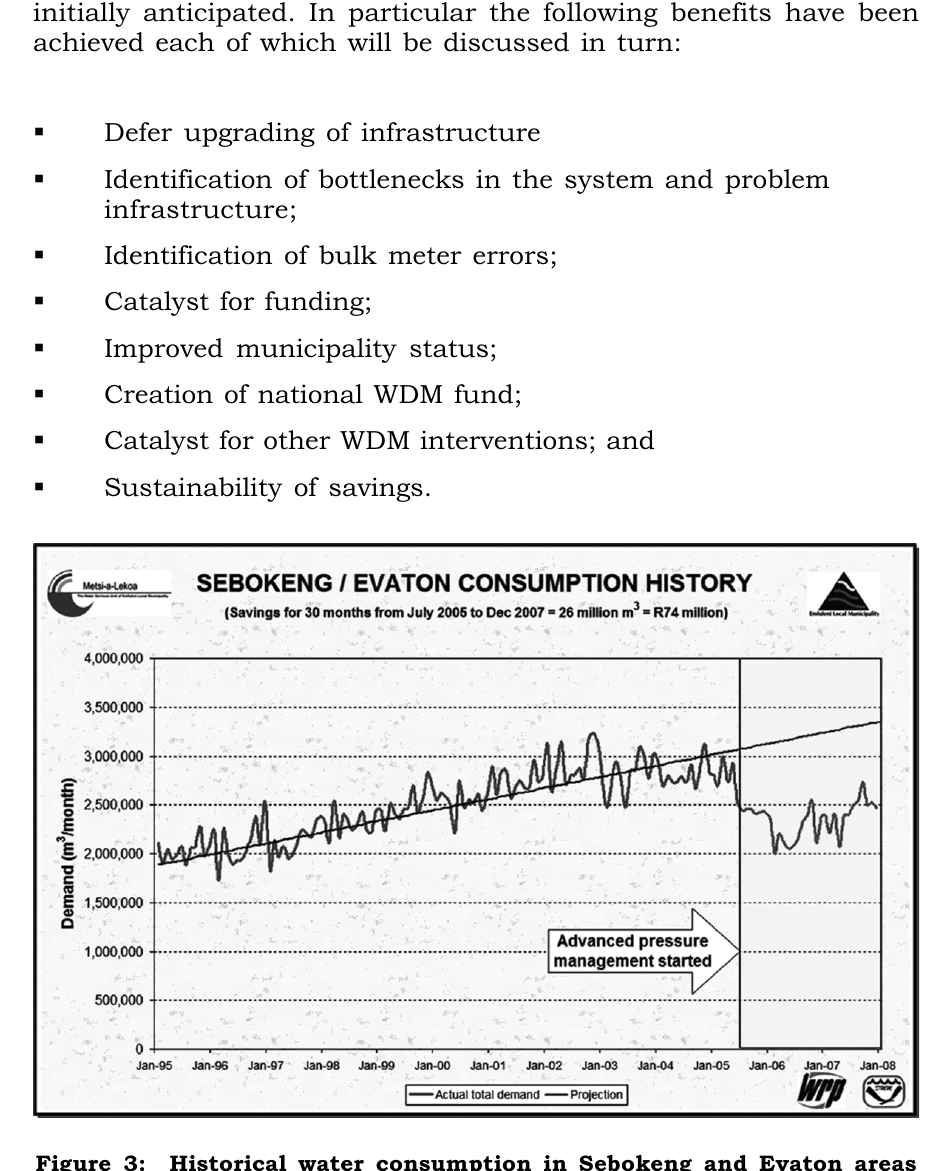
Figure 3: Historical water consumption in Sebokeng and Evaton areas for a 13 year